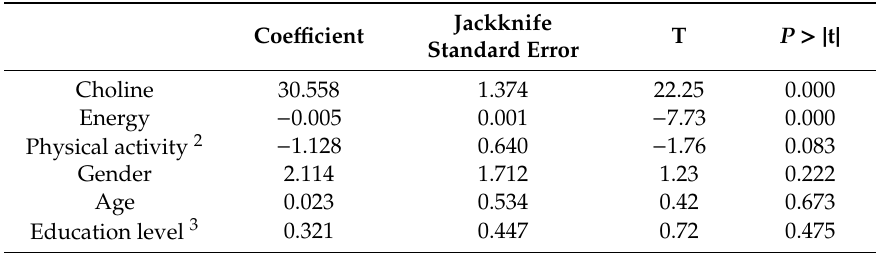
Table 3. Linear regression outcomes of the egg products and dishes food group for choline intake in the 2011–12 NNPAS 1 ( n = 21,526,456).